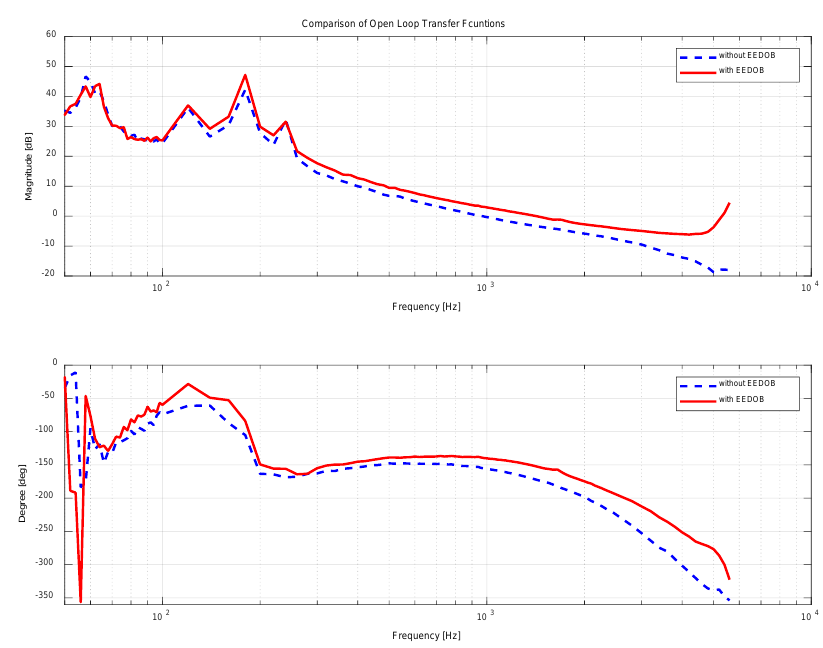
Figure 11. Measured open loop transfer functions.